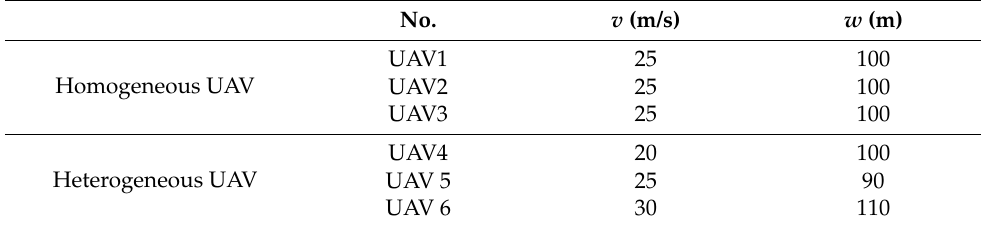
Table 2. The performance parameters for homogeneous and heterogeneous UAV.